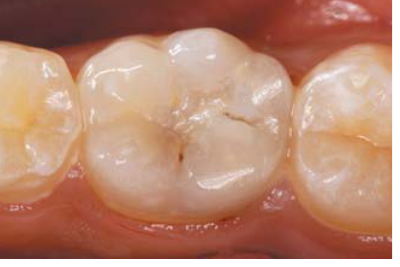
FIGURE 2 - Initial periapical radiograph showing deep caries lesion and normal